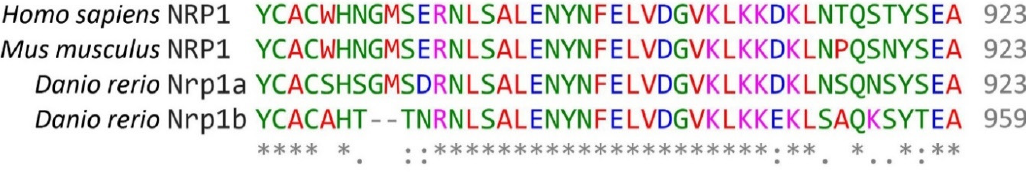
Figure 1. Alignment of the C-terminal amino acid sequence of human NRP1, mouse NRP1 and zebrafish Nrp1a and Nrp1b, including the complete cytoplasmic domain. Alignment performed with Clustal Omega (European Bioinformatics Institute; EBI). Asterisks indicate positions at which residues are conserved in all three species; colons and period indicate residues that are semi-conserved, i.e., have strongly or weakly similar properties, respectively. Color coding: red, small and hydrophobic residues; blue, acidic residues; magenta, basic residues; green, hydroxyl, sulfhydryl and amine residues and glycine.